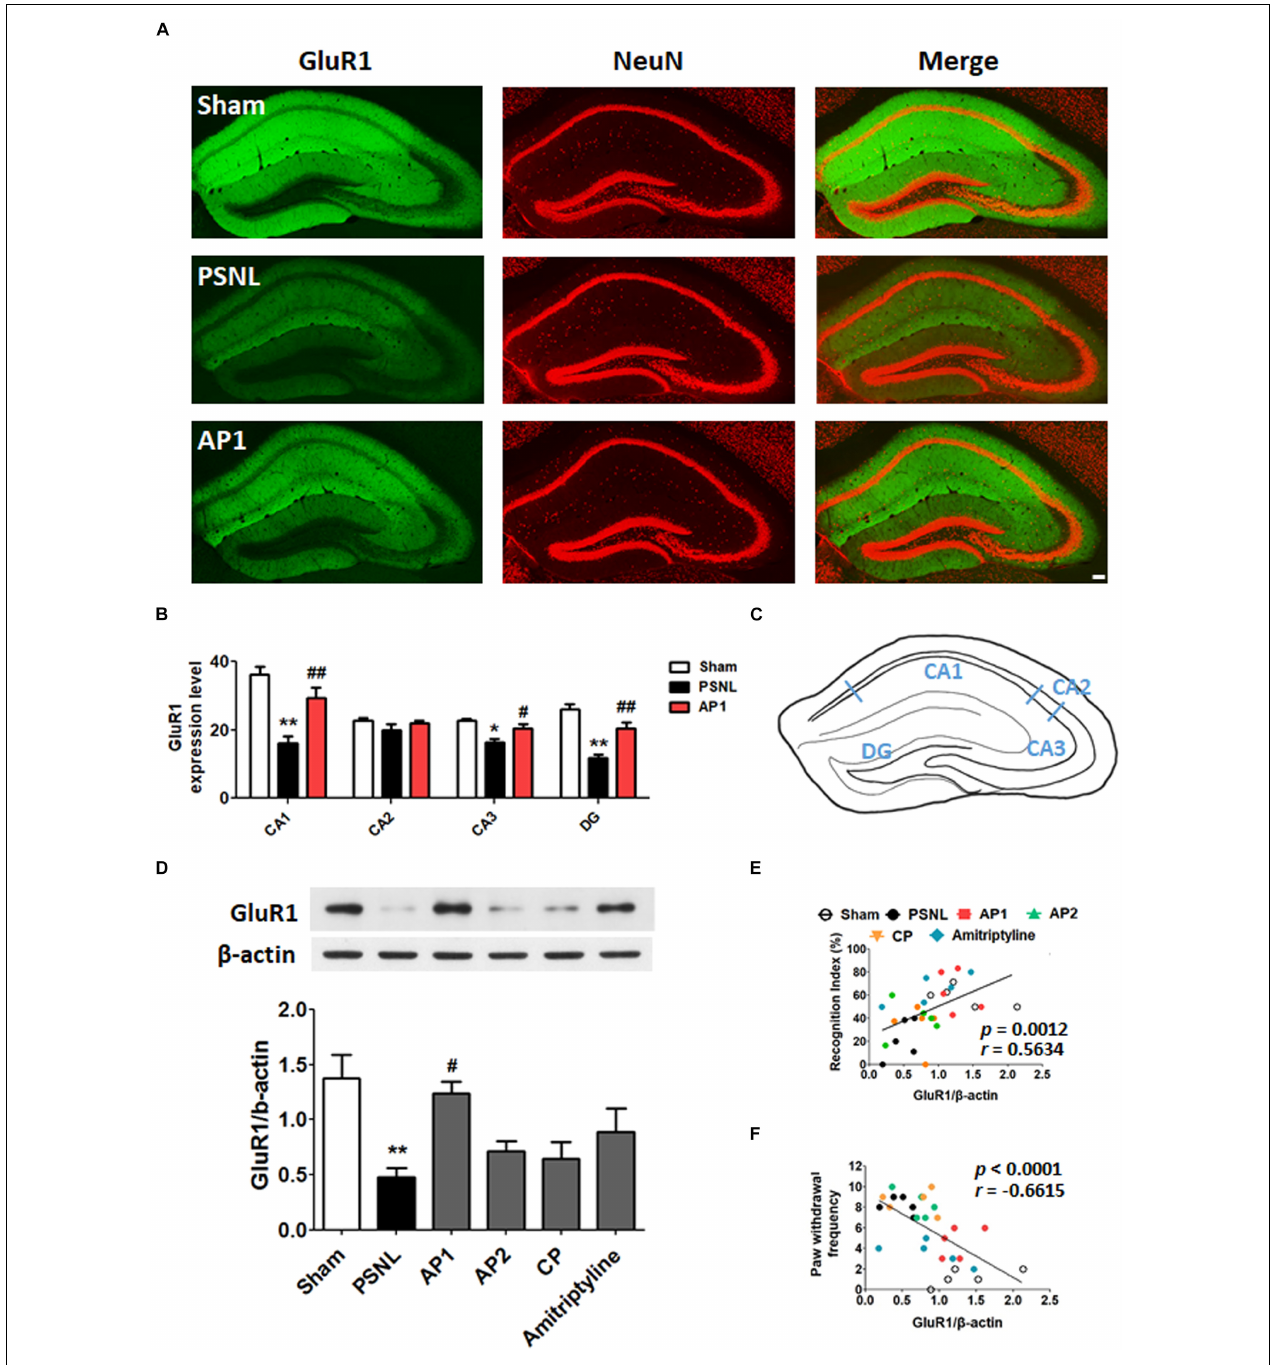
FIGURE 6 | Effects of acupuncture on the expression levels of hippocampal GluR1 receptor. These results show the changes in hippocampal GluR1 expression levels (CA1, CA2, CA3, and DG) after administration of acupuncture (AP1, AP2, or CP) or amitriptyline (10 mg/kg, i.p.) for 28 consecutive days (A–F) . Free-floating coronal hippocampus sections from the three groups (Sham, PSNL, and AP1) were subjected to immunofluorescence with GluR1 (green) and NeuN (red) antibodies to label GluR1-positive NeuN in neurons (A) . Representative graphs showing the expression levels of GluR1 in the hippocampus (A,B) and a representative figure showing the hippocampal regions in the mouse brain (C) . n = 3–4/group. Scale bar: 100 µ m. ∗ p < 0.05, ∗∗ p < 0.01 compared to the Sham group in each area. # p < 0.05, ## p < 0.01 compared to the PSNL group in each area. The expression levels of hippocampal GluR1 protein were examined (D) . n = 5/group. ∗∗ p < 0.01 compared to the Sham group. # p < 0.05 compared to the PSNL group. All data were analyzed with a one-way ANOVA followed by Newman–Keuls post hoc tests. All data are expressed as the mean ± SEM. The cognitive function values in the NOR test and nociceptive values in the von Frey test were correlated with the GluR1 protein levels in the hippocampus (E,F) . The r -values were analyzed with the Spearman rank correlation coefficient. AP1, acupuncture 1 (GB30 and GB34); AP2, acupuncture 2 (HT7 and GV20); CP, control point.